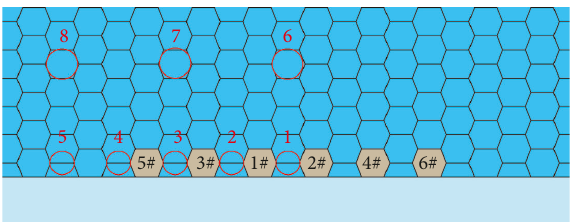
Figure 15: Layout of stress measurement circles and drifts mining sequence (Circles 1–8 are stress measurement circles; the mining sequence of the drifts is from 1 # to 6